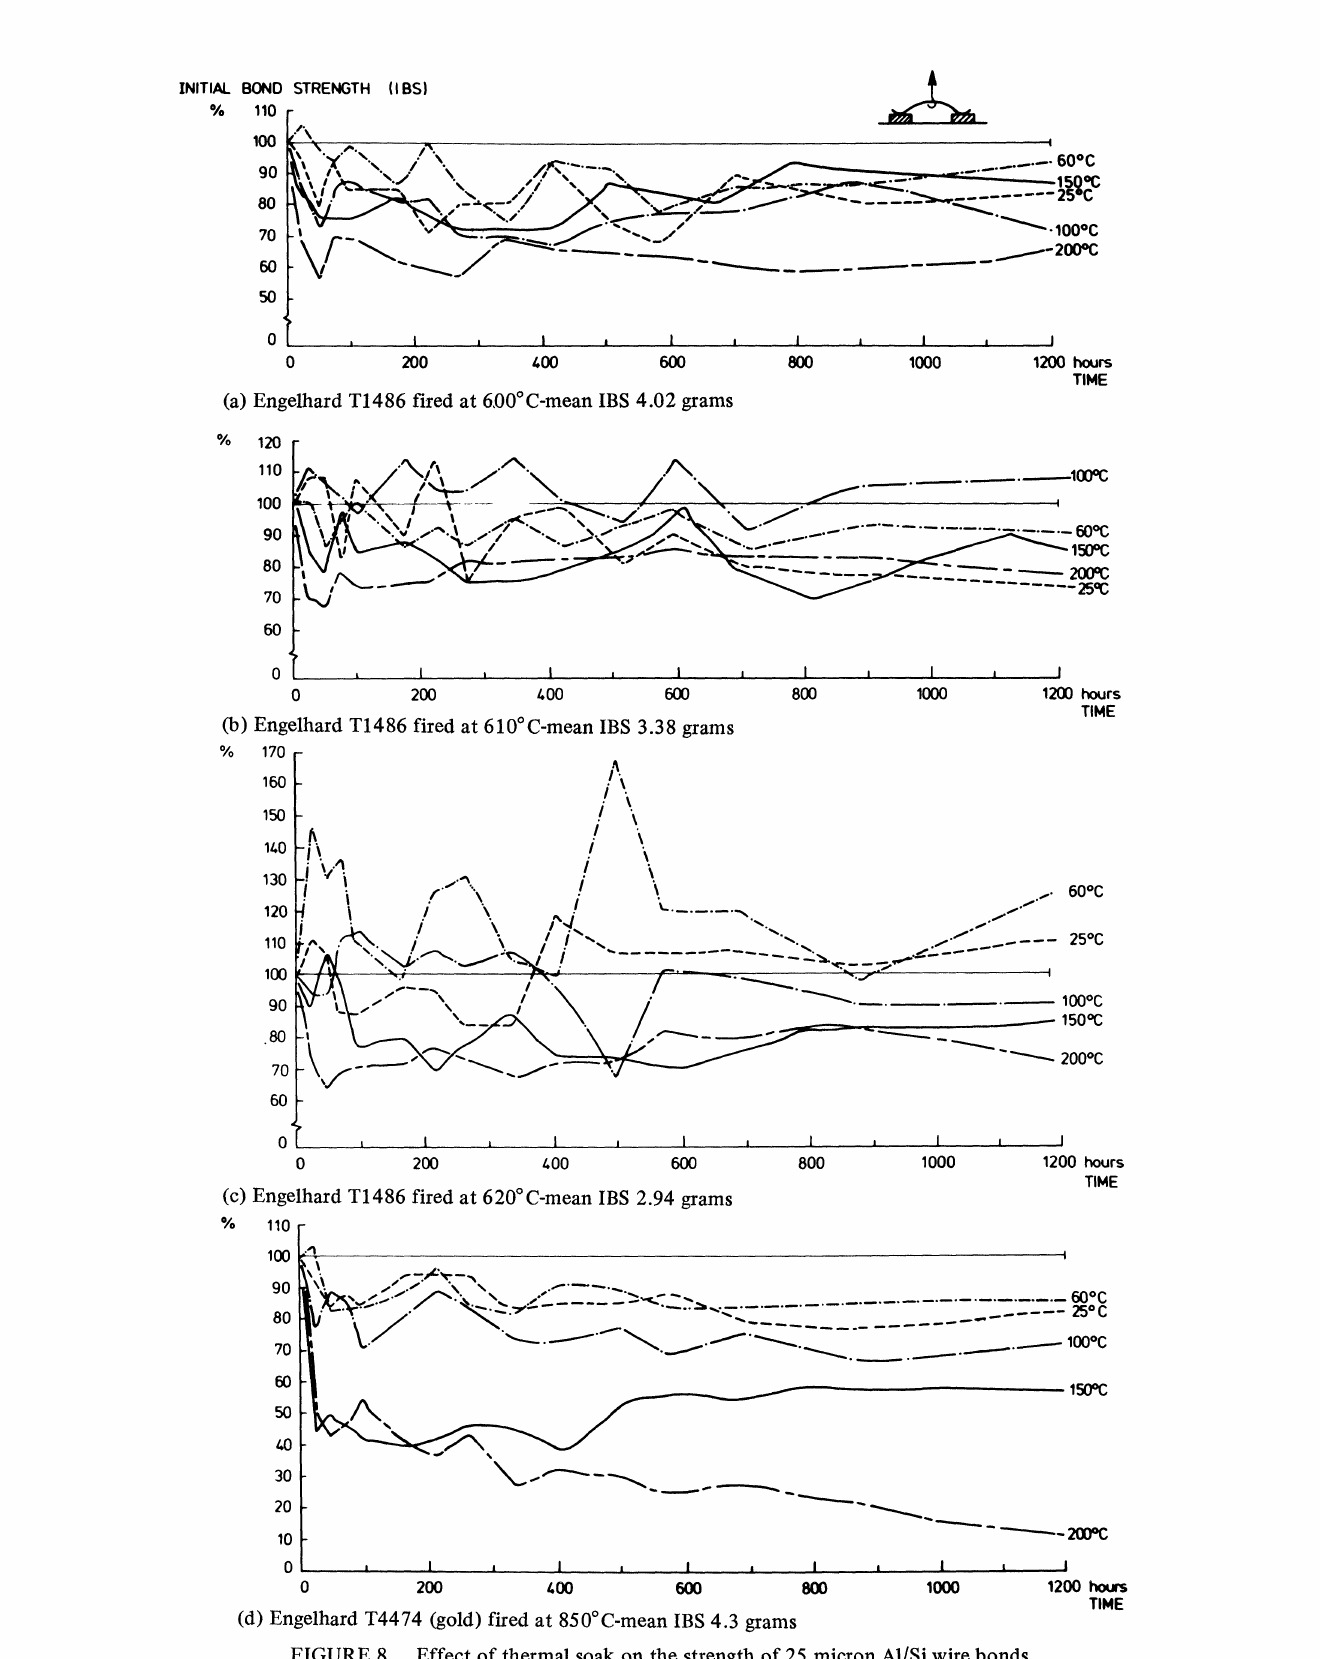
FIGURE 8 Effect of thermal soak on the strength of 25 micron A1/Si wke